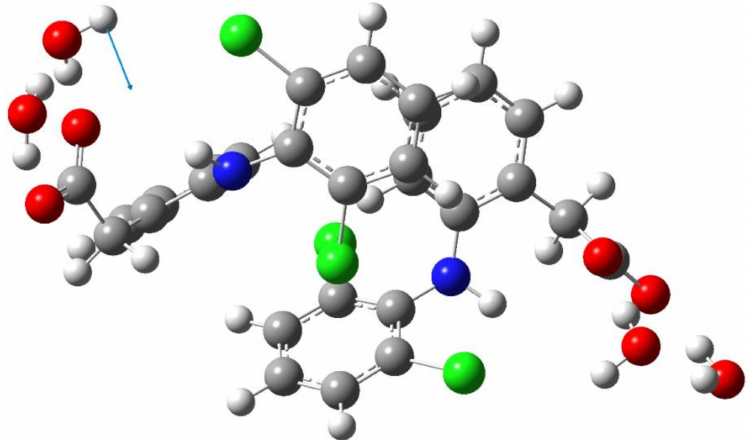
Figure 6. Schematic representation of the torsion vibration of the water molecule (247 cm − 1 ) in dimer of the diclofenac anion hydrated with four water molecules. The arrow indicates the direction of the relative displacement of the H